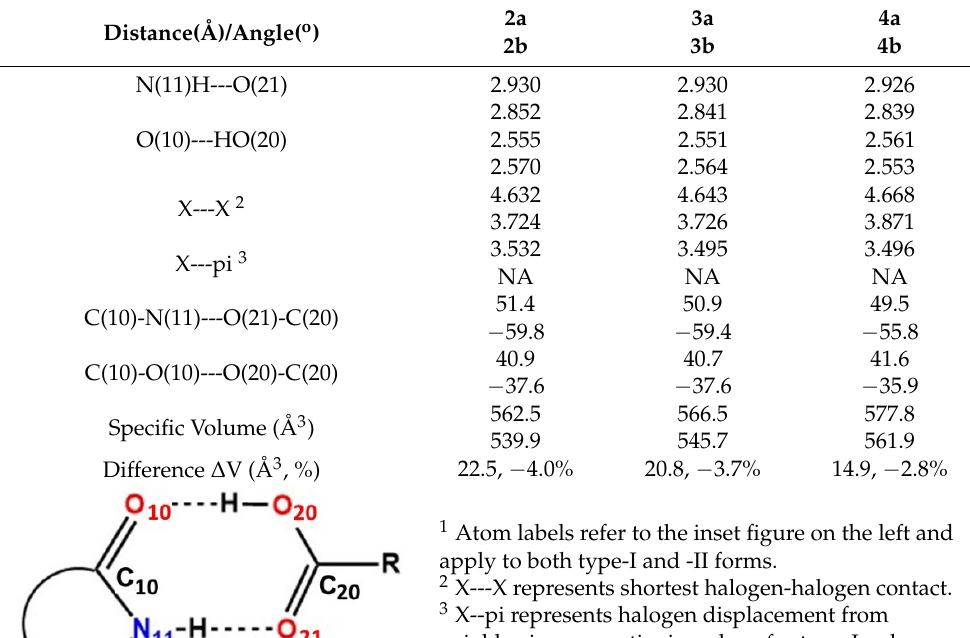
Table 3. Supramolecular geometric comparison for Type I ( a ) and II ( b ) polymorphs. 1.